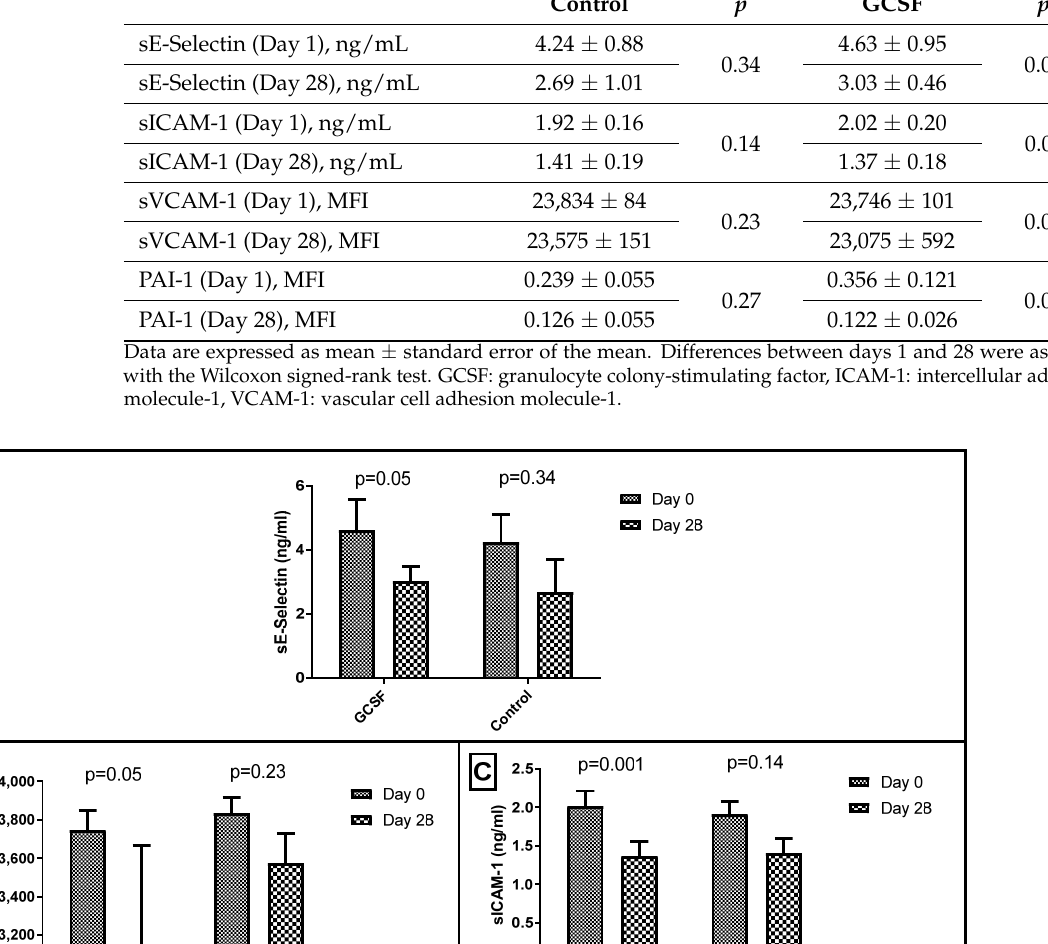
Table 1. Differences in soluble (s) adhesion molecules and plasminogen activator inhibitor-1 (PAI-1) between days 0 and 28 in the control and GCSF group. Control p GCSF p sE-Selectin (Day 1), ng/mL